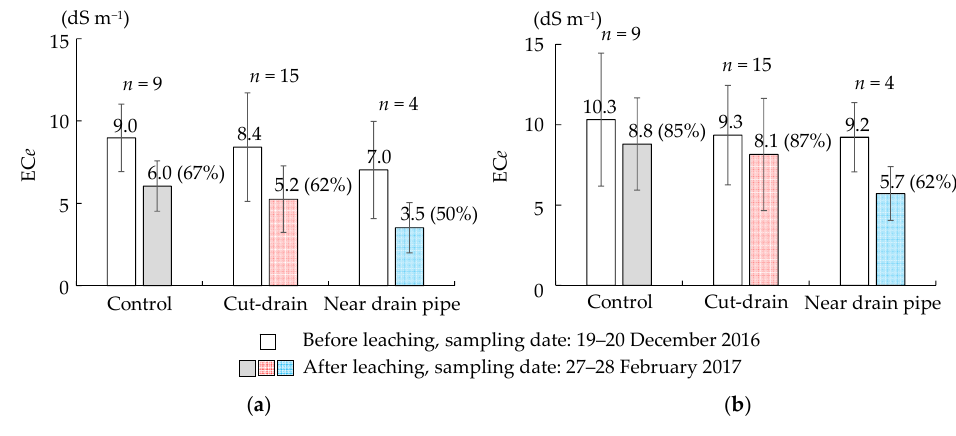
Figure 9. Changes in soil salinity before and after leaching: ( a ) Upper layer (0–60 cm); ( b ) lower layer (60–100 cm). Error bars represent the standard deviation. The figure above the bar shows the EC e . The figures between parentheses show the percentage of EC e after leaching to that before leaching. The n represents the number of the sampling points. The analysis of variance resulted in no significant di ff erences ( p < 0.05).